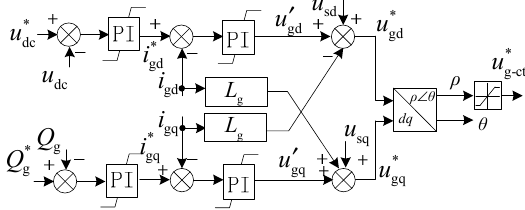
Figure A2. Control diagram of the GSC.